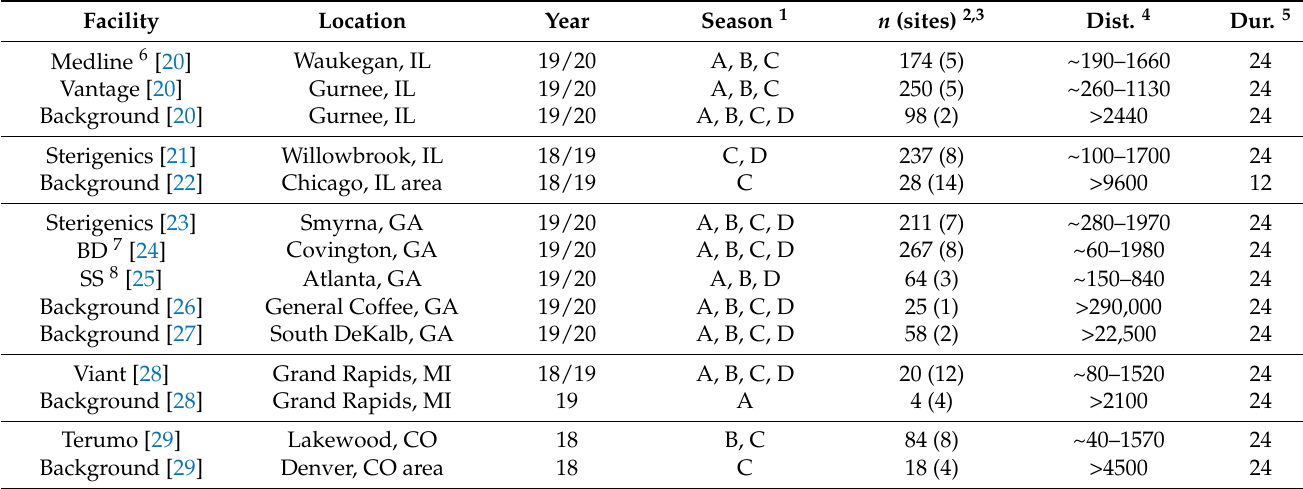
Table 1. Summary of publicly-available datasets concerning ambient EO concentrations in the vicinity of seven sterilization and one other EO-emitting industrial facility 1 and at corresponding representative background